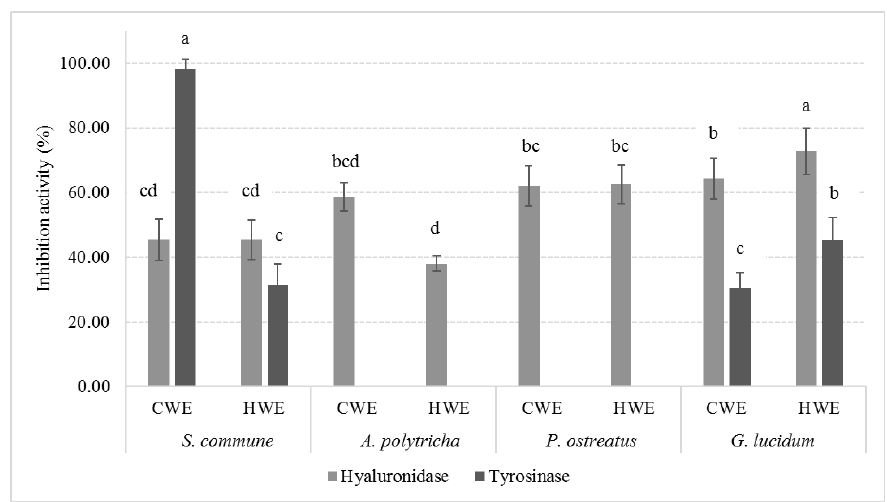
Figure 4. Hyaluronidase and tyrosinase inhibition activity of extracts from multiple types of mushroom. The values with the same letter in each category are not significantly different at p > 0.05 by one-way ANOVA.